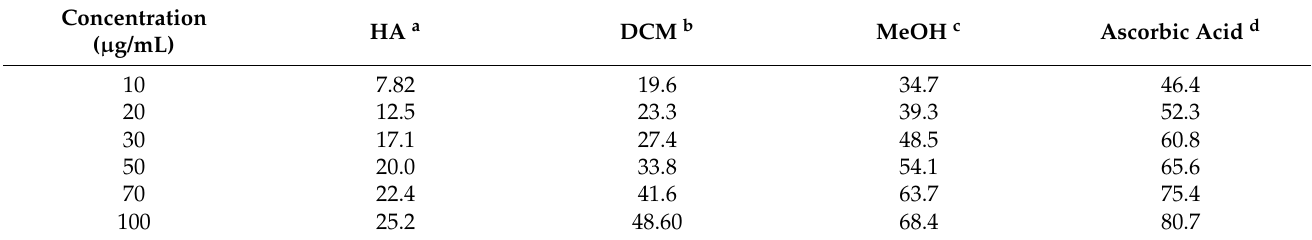
Table 6. Ferric reducing activity of three extracts of N. mexicana Zucc